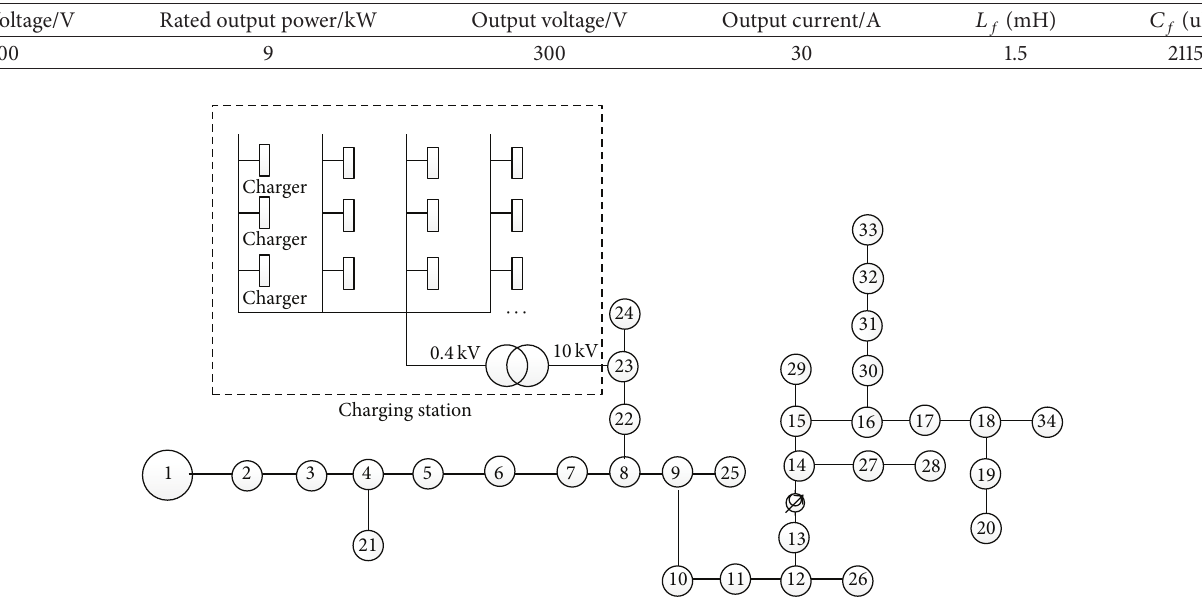
Table 2: Parameters of the EV charger.